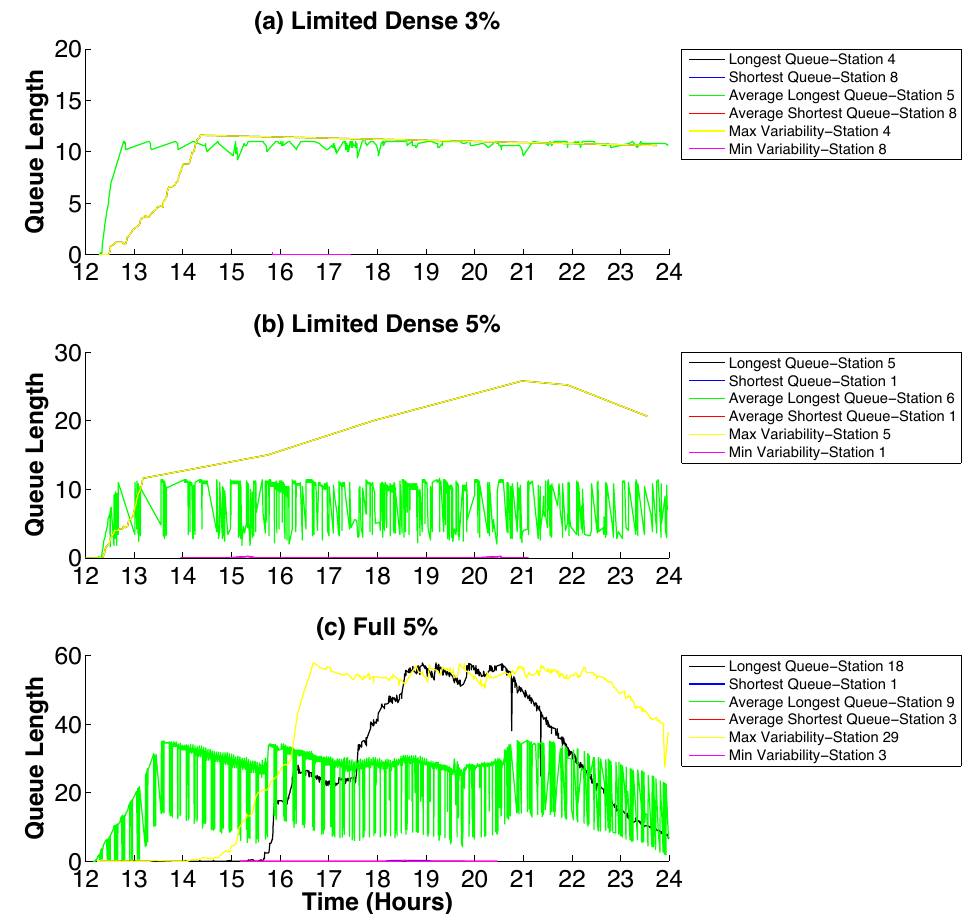
Figure 10. Queue length in time in three indicative